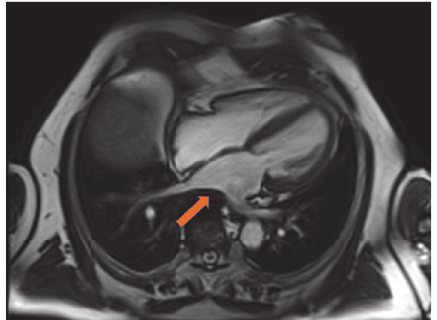
Figure 3: Magnetic resonance image of the heart showing the osteophyte protruding into the left